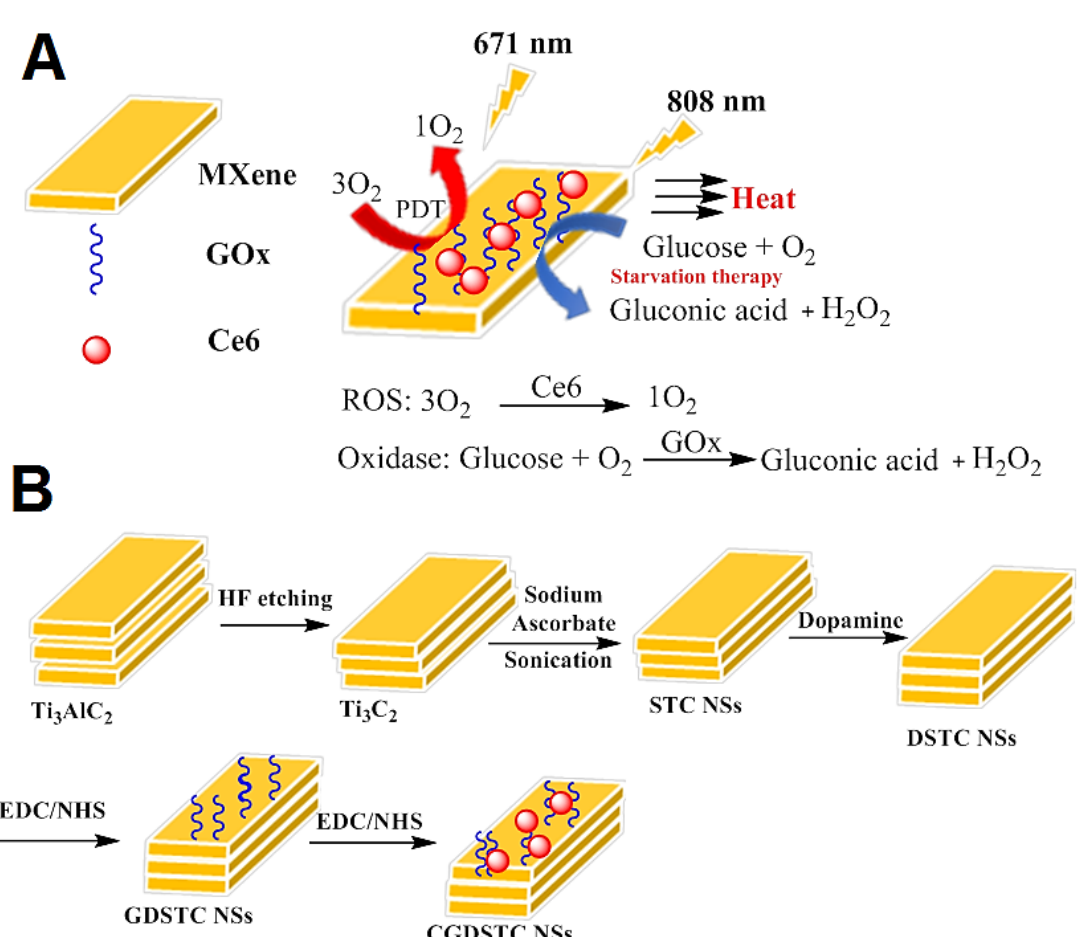
Figure 7. ( A ) Pictorial representation for the working mechanism of CGDSTC nanosheets. ( B ) The preparative process of CGDSTC nanosheets [33]. preparative process of CGDSTC nanosheets [33].